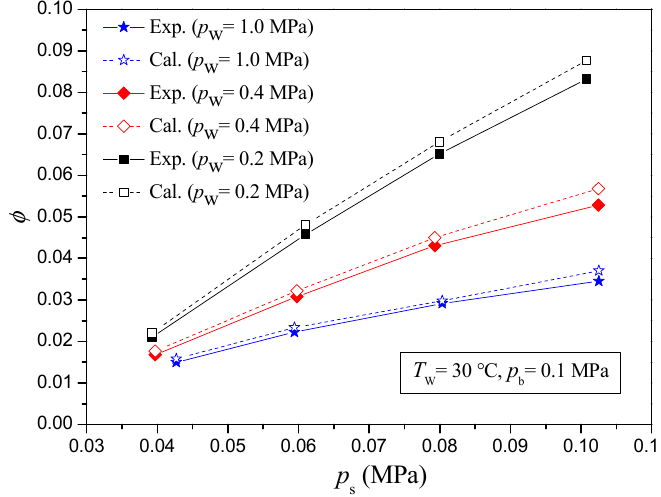
Figure 5. ϕ comparisons for different inlet steam pressures. Figure 5. φ comparisons for different inlet steam pressures.